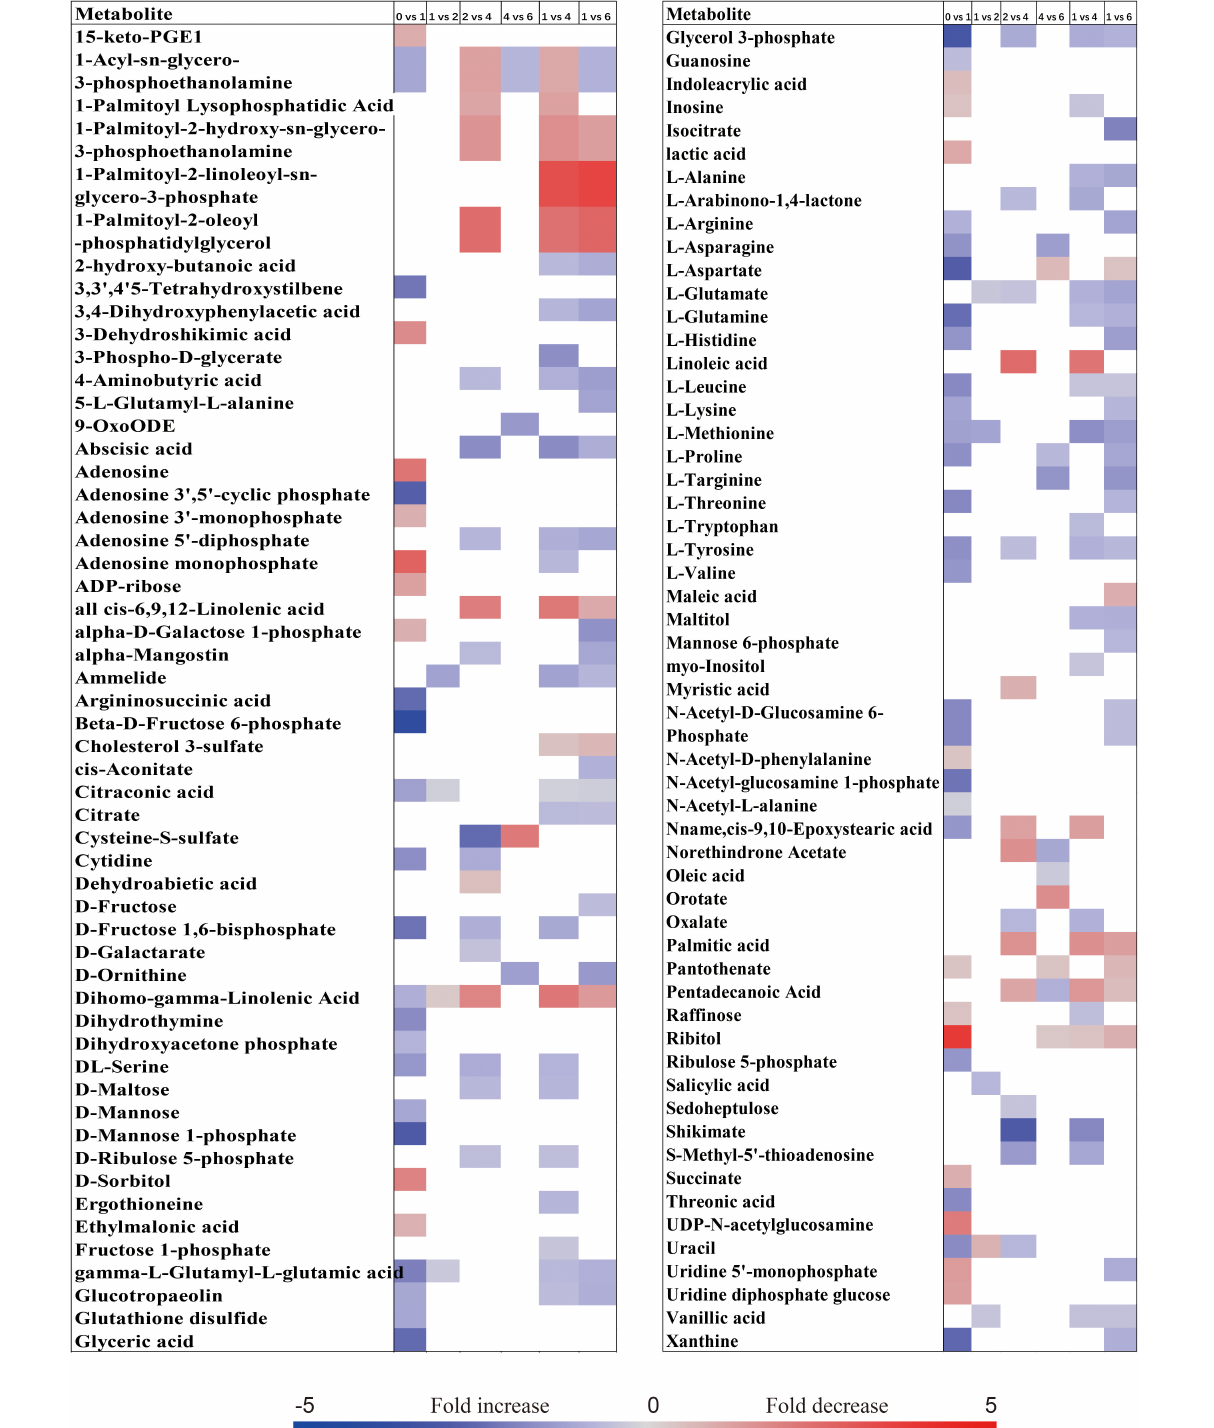
Frontiers in Plant Science |